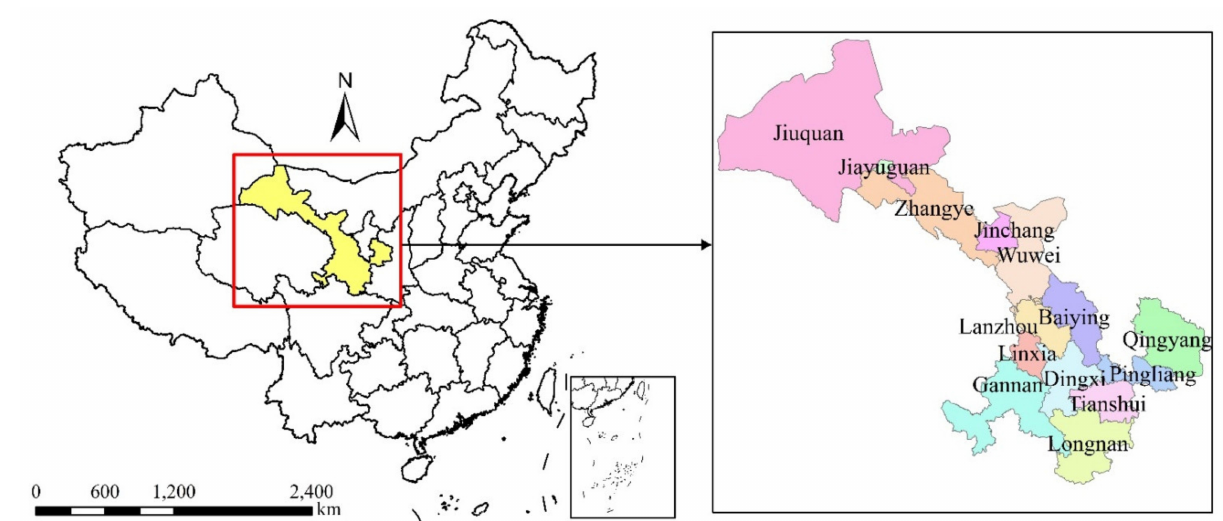
Figure 1. Geographical location of Gansu